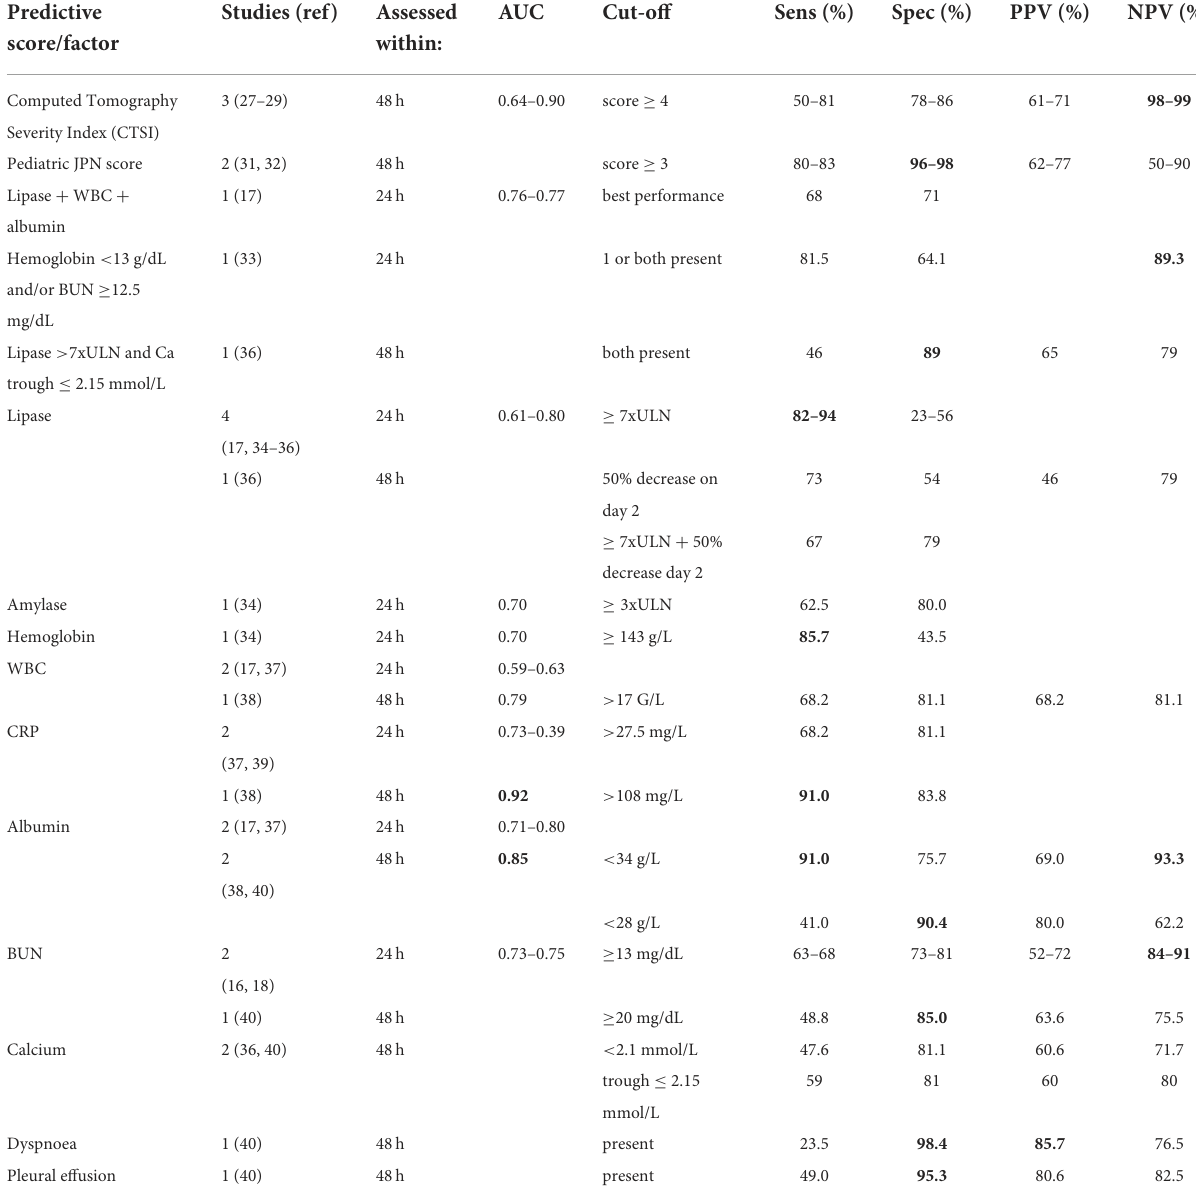
TABLE 2 Summary of predictive performance parameters presented by the included